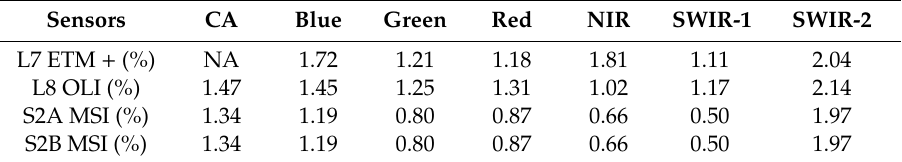
Table 10. Sudan 1 random error (precision) between measured and simulated values.